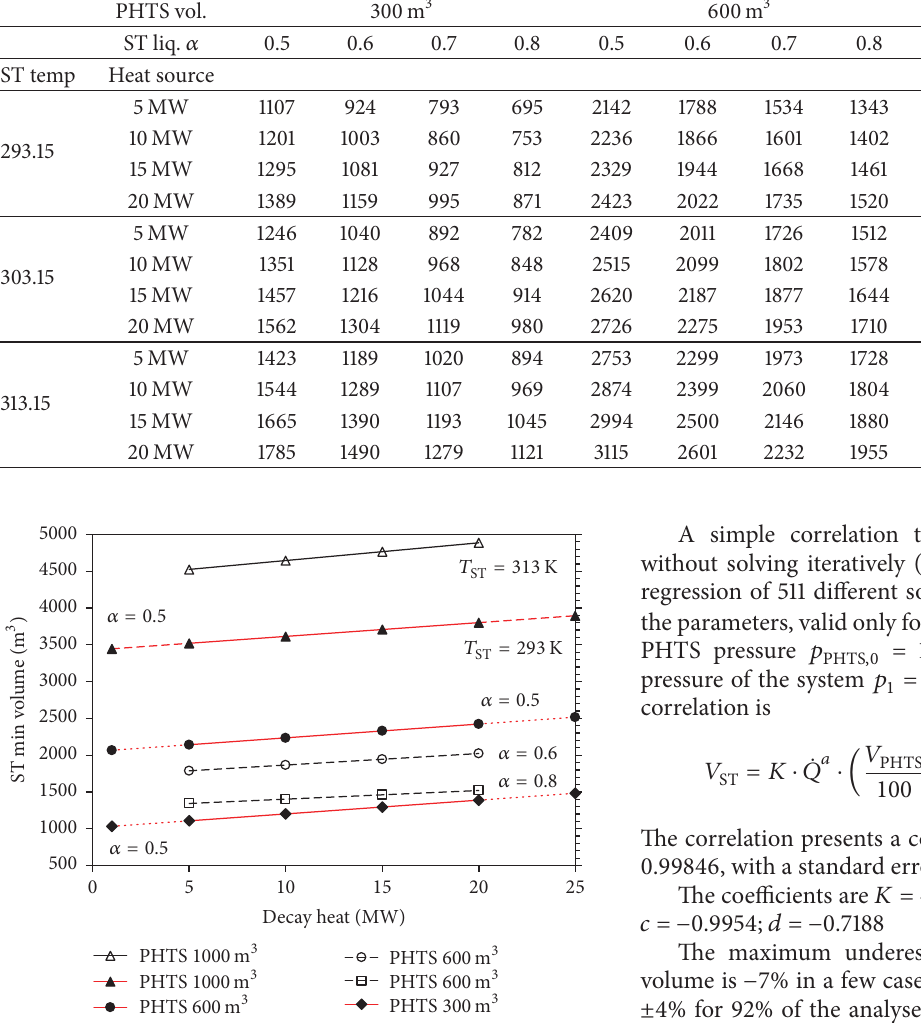
Figure 2: Sensitivity analysis on the decay